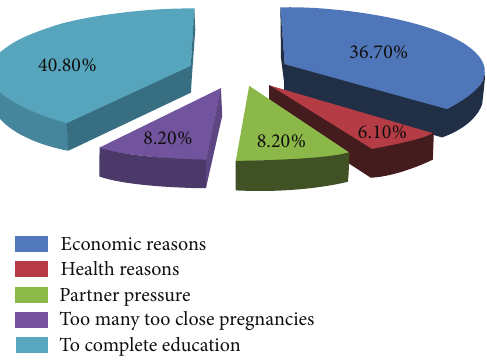
Figure 1: Reasons for interference with the current pregnancy among post-abortion clients in Guraghe zone, south Ethiopia, from January to March,